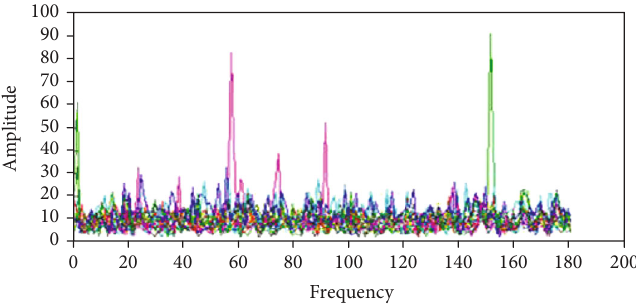
Figure 7: Power spectrum in the case of close eyes. Di ff erent colors denote di ff erent EEG channels.